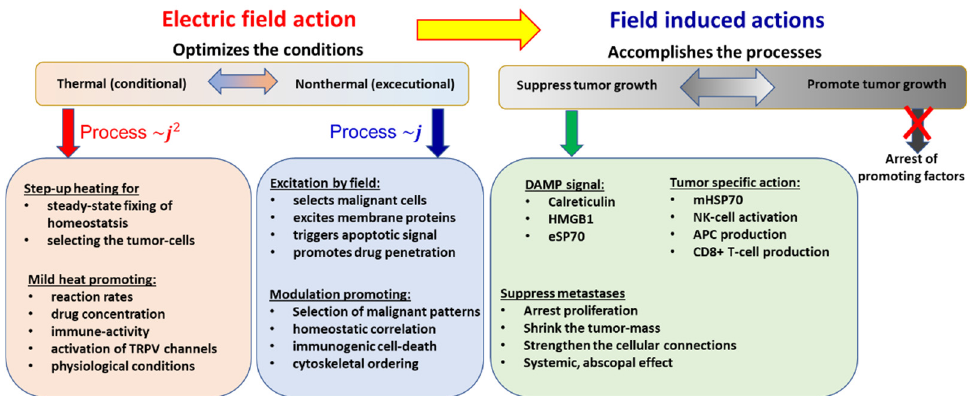
Figure 14. The processes of thermal and nonthermal effects of selective, heterogenic heating. The field-induced actions are complex, requiring both the thermal (conditional) and nonthermal (excitation) processes.